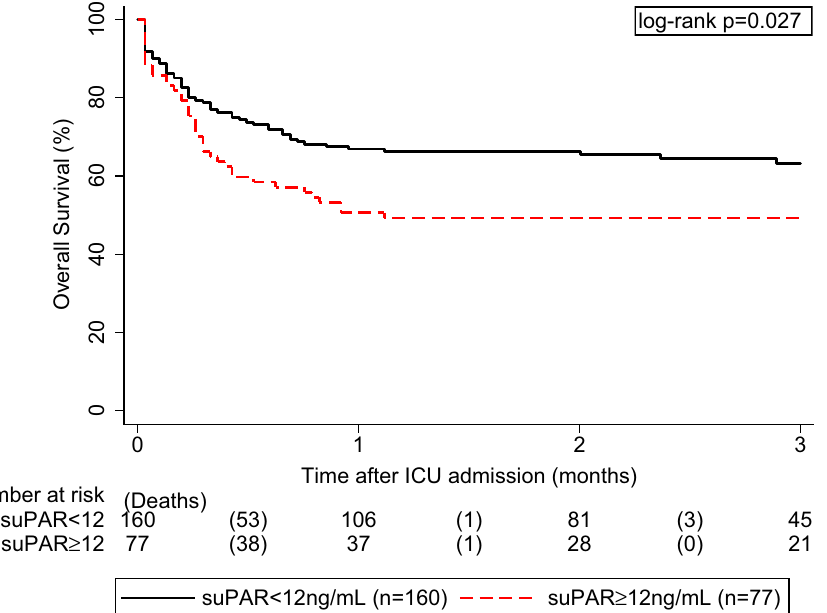
Figure 3. Overall survival for suPAR levels above or below a 12 ng/mL cutoff. Median follow-up of the total cohort was 2.9 months with 96 observed deaths from any cause. Using a previously published suPAR cut-off at 12 ng/mL for validation, Kaplan–Meier overall survival estimates at 3 months were 63% in the 160 patients with baseline suPAR levels below 12 ng/mL, and 49% in the 77 patients with baseline suPAR levels ≥ this cut-off (log- rank p =